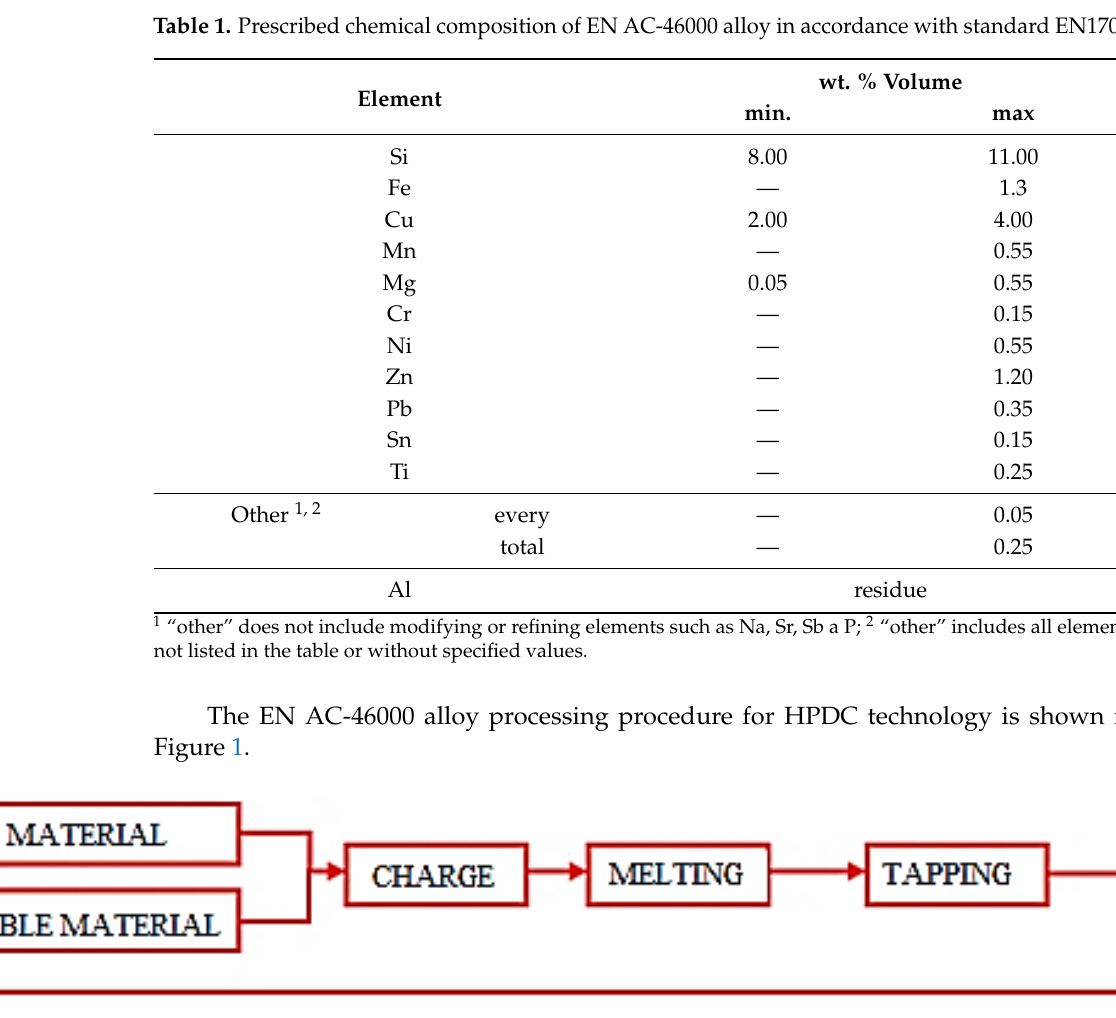
Table 1. Prescribed chemical composition of EN AC-46000 alloy in accordance with standard EN1706.